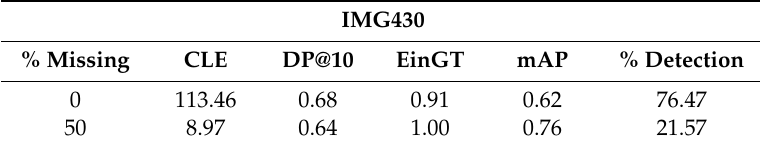
Table 4. Performance metrics for 0 and 50 percent missing pixels. JHU fire escape scenario: Video IMG430.